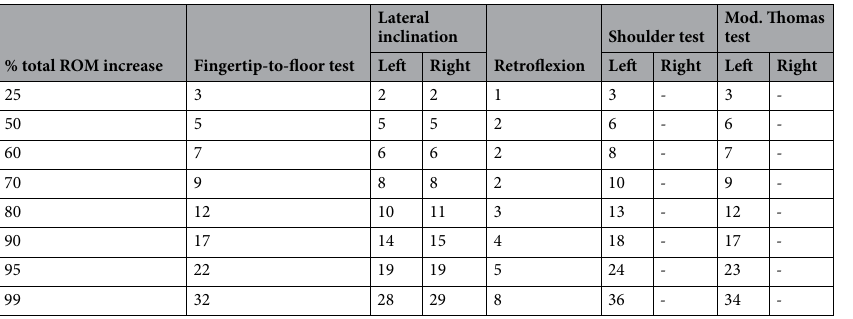
Table 2. Relative ROM gain dependent on the number of repetitions for each ROM